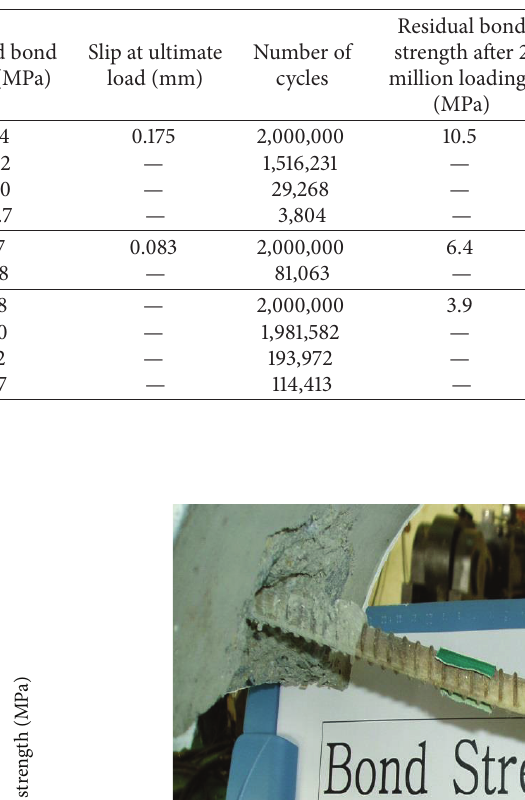
Table 2: Stress levels in the fatigue bond test.